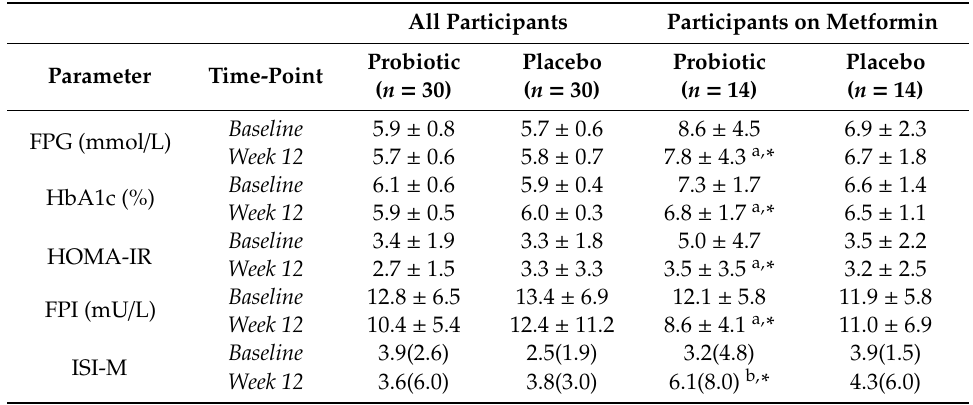
Table 2. Glycaemic parameters and insulin sensitivity indices by intervention group and within participants taking